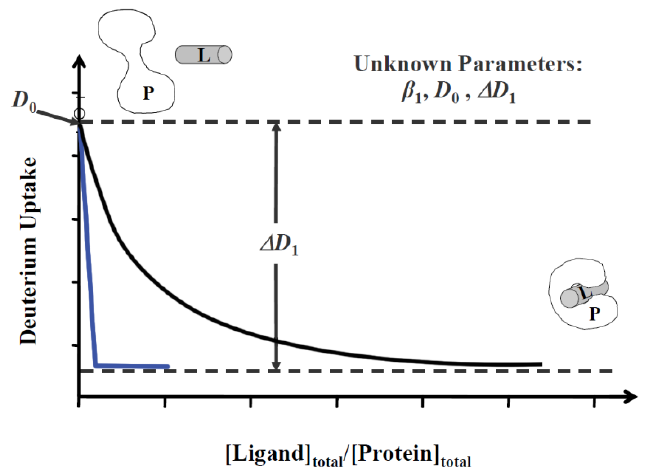
Figure 2. Schematic illustration of a PLIMSTEX curve generated by titration of a protein with a ligand and with detection by HDX-MS. Adapted with permission from Ref. [68]. Copyright 2005 Elsevier.